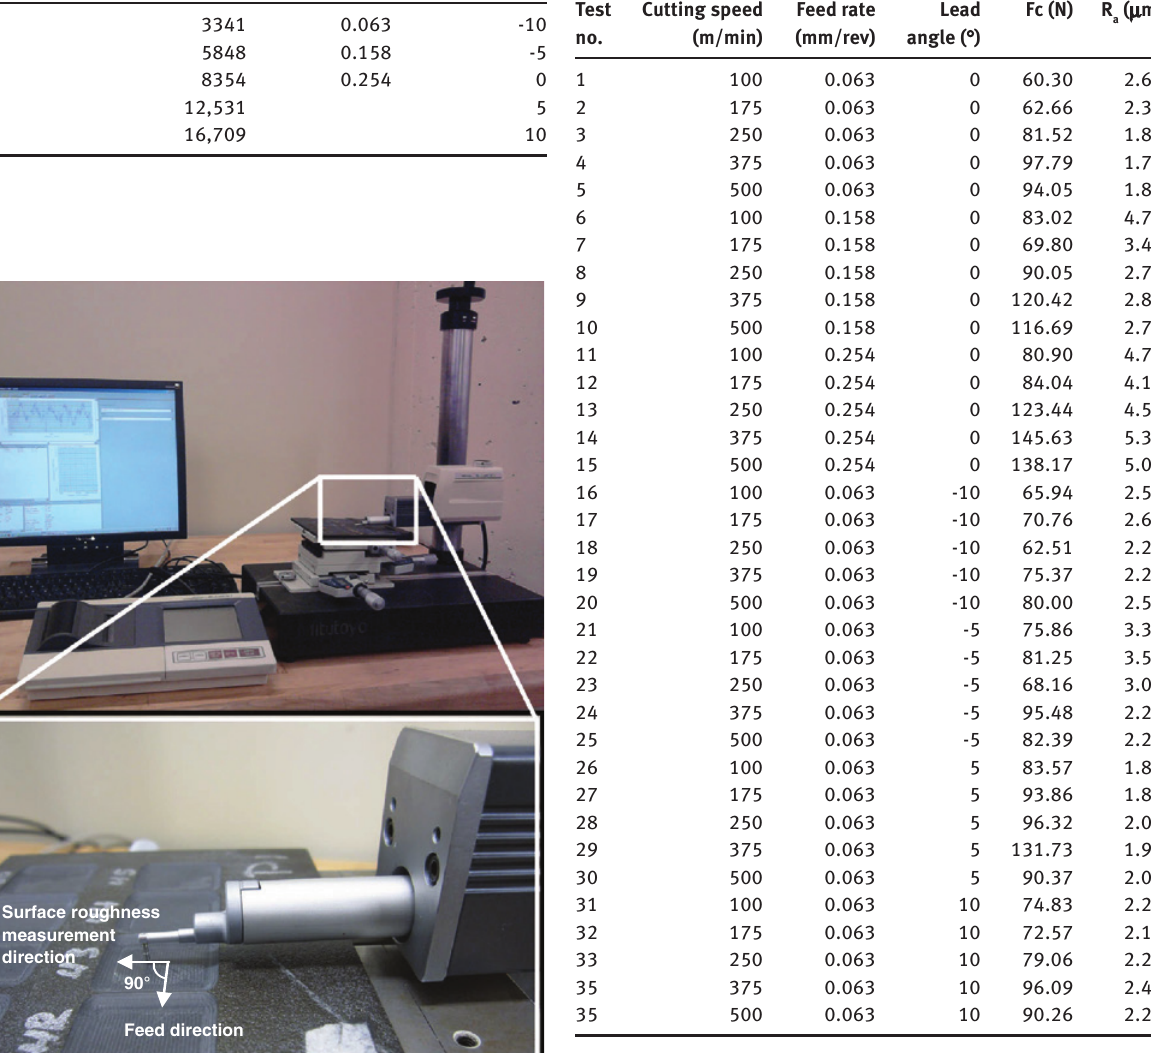
calculated. The measured values of R (arithmetic average a height) and R (total height of the roughness profile) in dif- t ferent cutting conditions were compared to investigate the effect of cutting conditions on the surface quality. Table 3